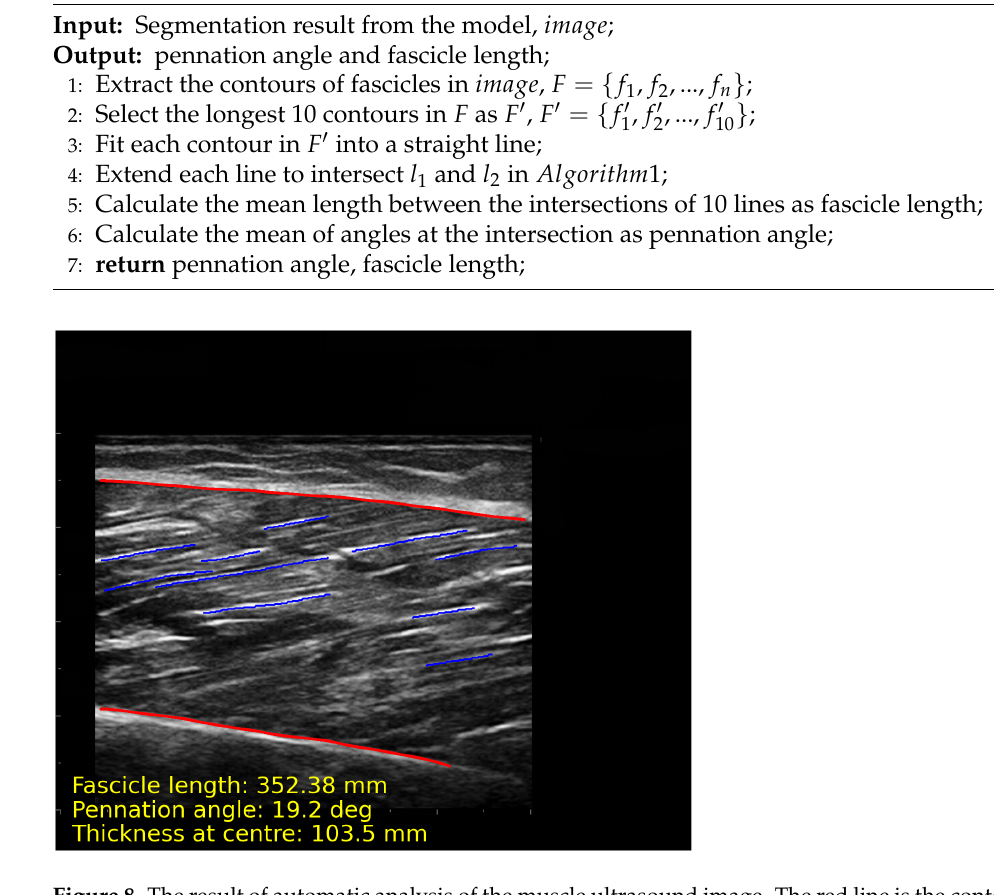
Figure 8. The result of automatic analysis of the muscle ultrasound image. The red line is the contours of aponeuroses, and the blue line is the longest 10 representative fascicles. The calculation results of muscle parameters are displayed at the bottom of the